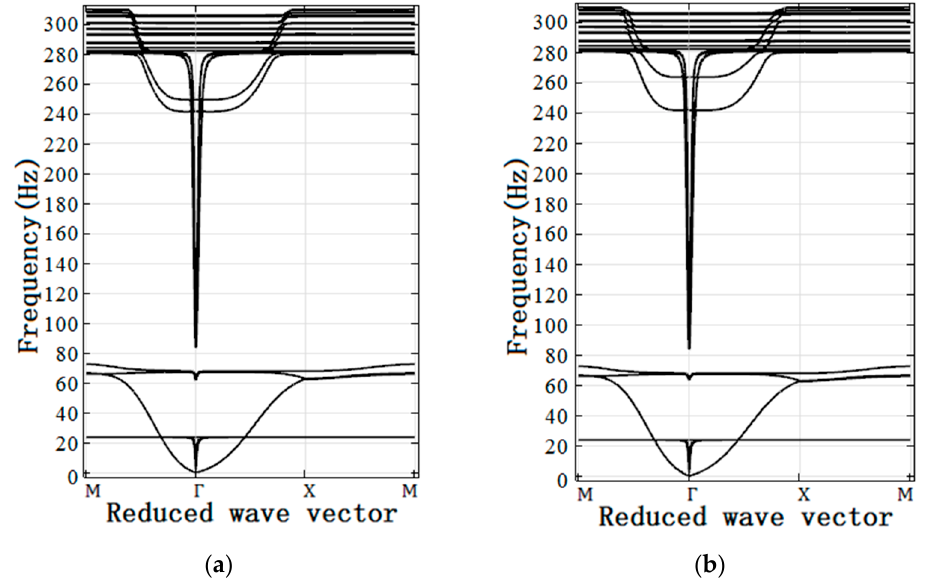
Figure 9. Band structures of LRPC DPSs if the elasticity moduli of the soft shell are ( a ) 𝐸 (cid:3028) (cid:3404)